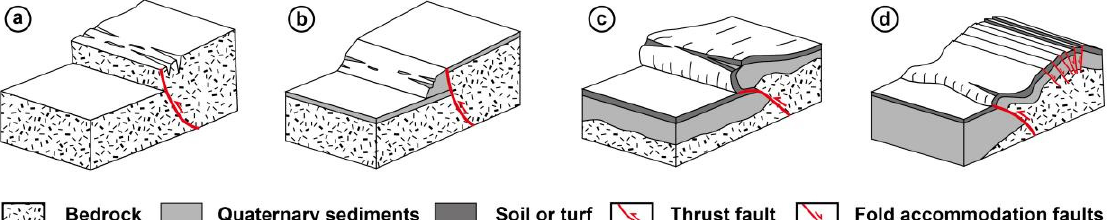
Figure 10. Typical surface structural deformation features developed along the ATF and KTF surface rupture zones. ( a ) bedrock scarp; ( b ) hanging wall collapse scarp; ( c ) pressure ridge; ( d ) main thrust faulting and bending-moment normal fault scarps. The moving and bending of the bed in the anticlinal hinge can amplify the bed curvature to generate bending-moment normal faults (as shown in Figure 8e) [50]. The structural models are modified after [59] .